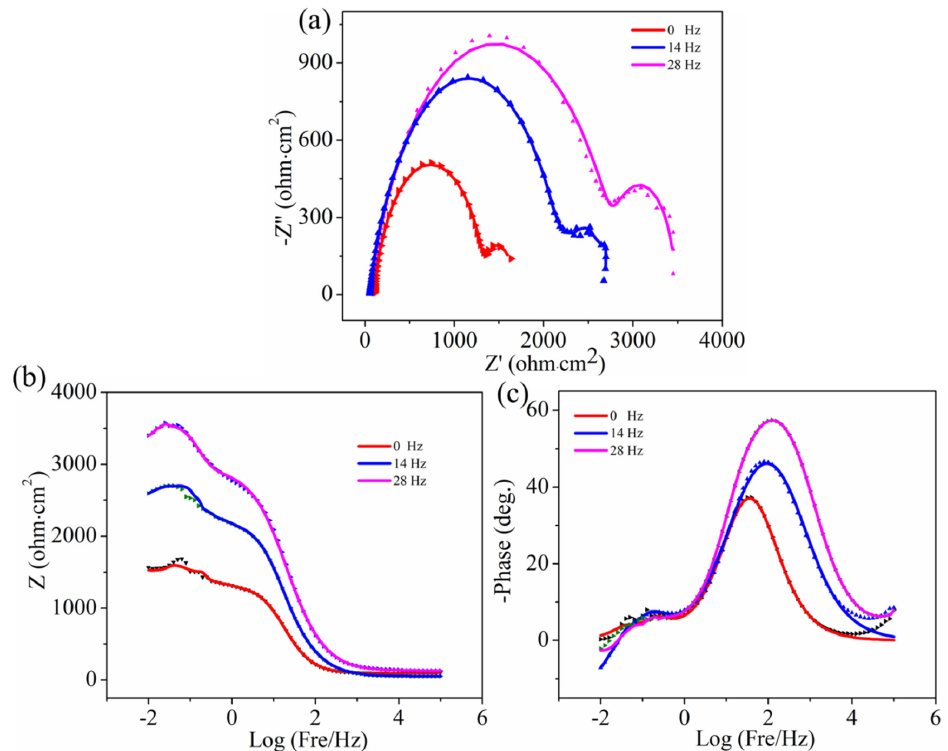
Figure 6. Anti-corrosive properties of ultrasonically treated fluoride coating via EIS tests: ( a ) Nyquist plots, ( b ) impedance magnitude and ( c ) phase angle of Bode plots. plots, ( b ) impedance magnitude and ( c ) phase angle of Bode